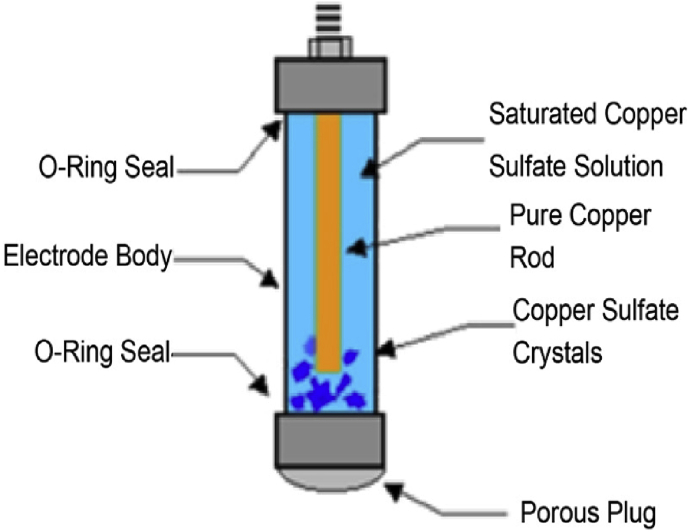
The Cu–CuSO4 reference electrode construction.